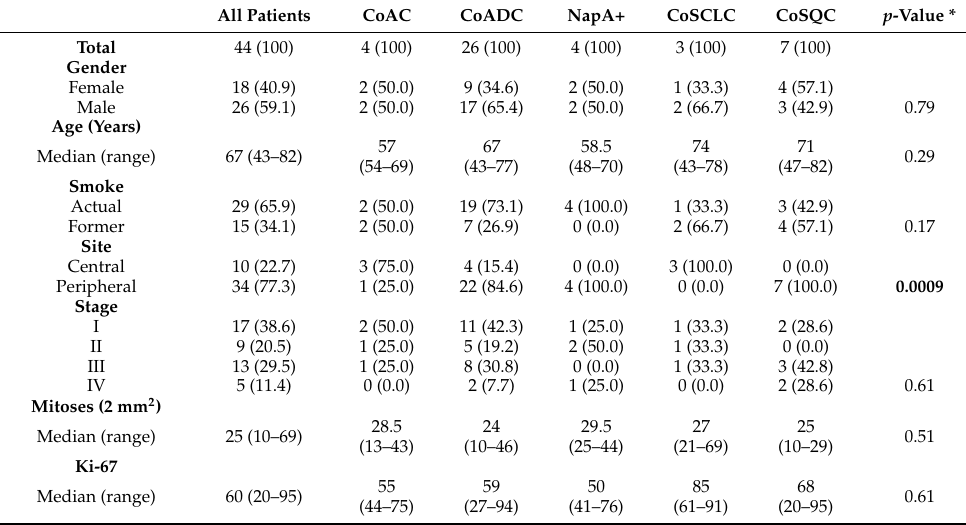
Table 1. Characteristics of the 44 patients with combined-LCNEC of the lung according to their non-LCNEC